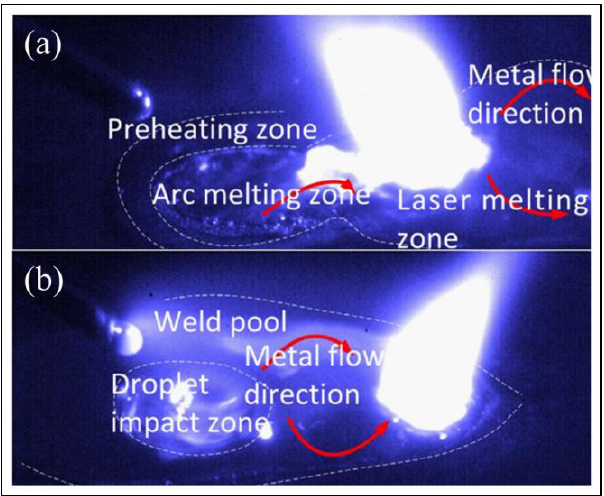
Figure 13. The information of weld pool: ( a ) arc leading mode; ( b ) laser leading mode [70]. Reprinted with permission from [70] 2014 Elsevier.